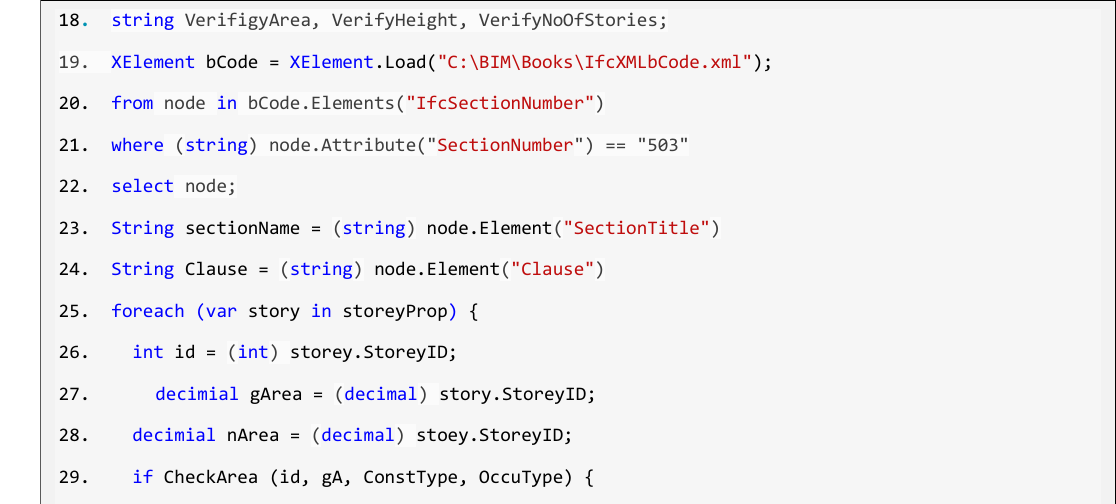
Figure 11. A part of the implementation